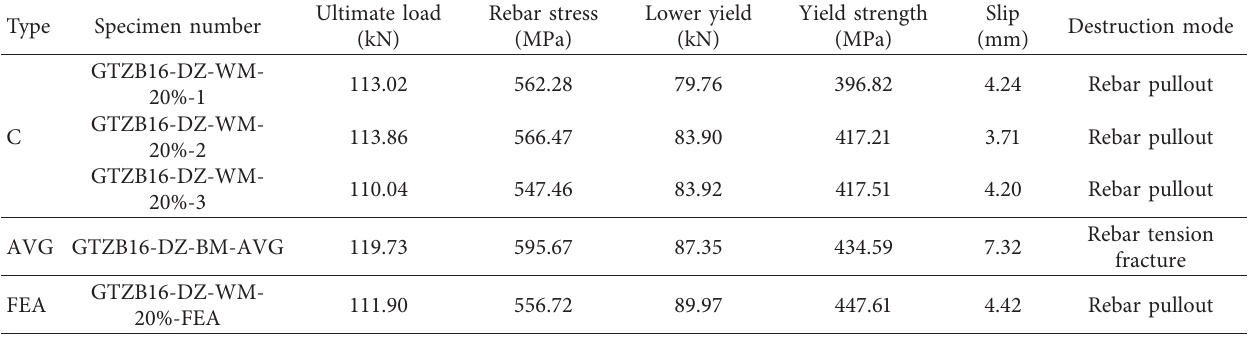
Table 6: Experiment and stimulation data of the insufficient compactness specimen.